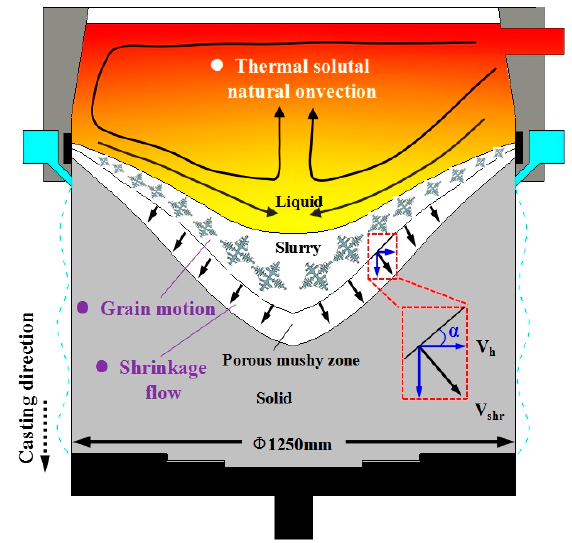
Figure 8. Schematic showing macrosegregation mechanism in a large-scale ingot.